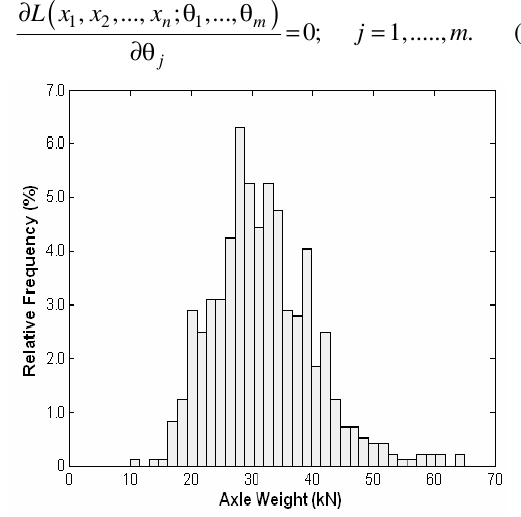
Fig 1. Frequency diagram for single axle weight